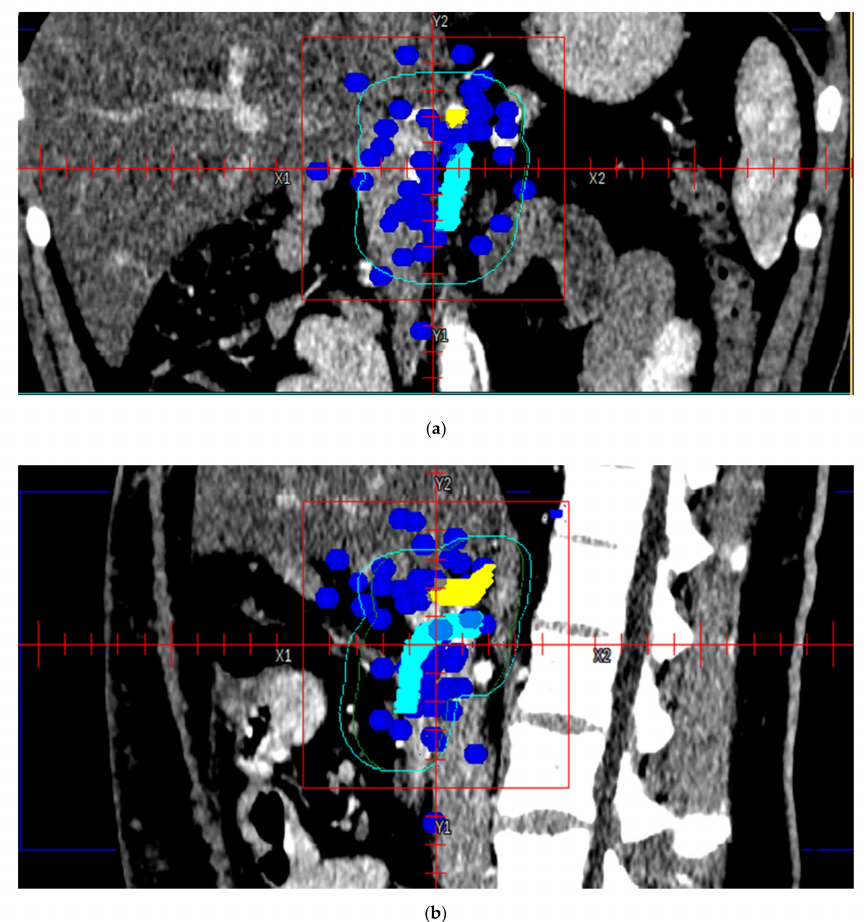
Figure 2. Local recurrence sites (blue symbols) plotted with respect to the pancreatic stump, CA (yellow) and SMA (cyan). The light blue line and green line represent CTV 90 Yu and CTV 90 Dholakia, respectively. Coronal ( a ) and sagittal view ( b ).